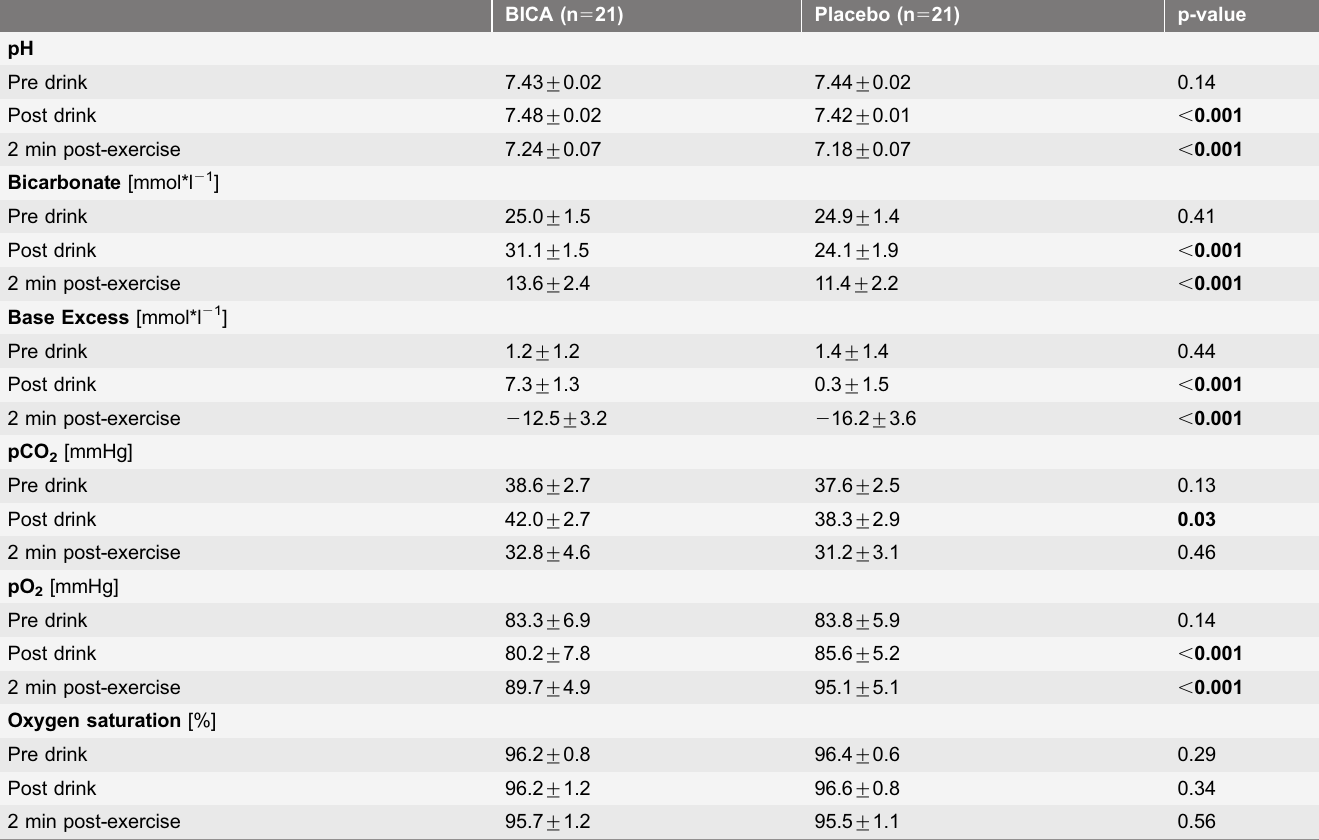
Table 2. Blood gas parameters before and after incremental